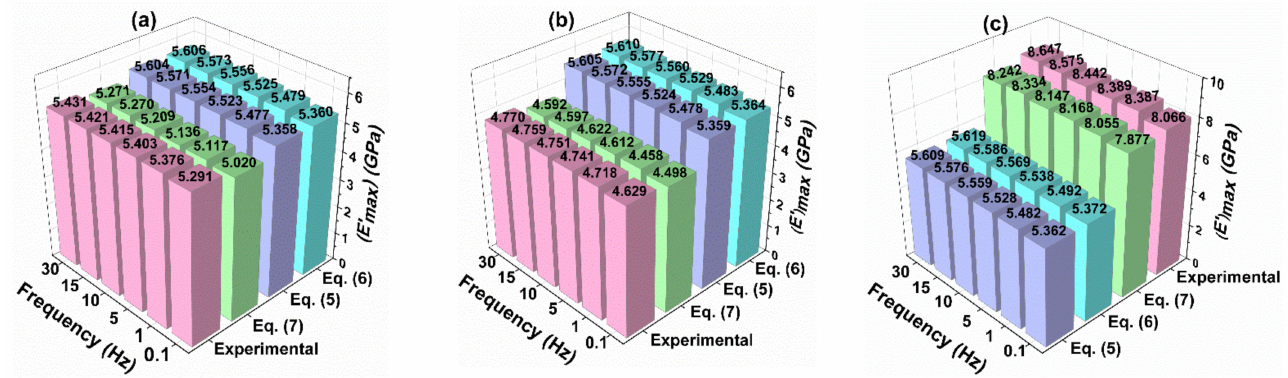
Figure 8. Comparison of experimental and predicted initial storage modulus values at different weight percentages of nanocomposites: ( a ) 0.05 wt%, ( b ) 0.1 wt%, and ( c ) 0.2 wt%